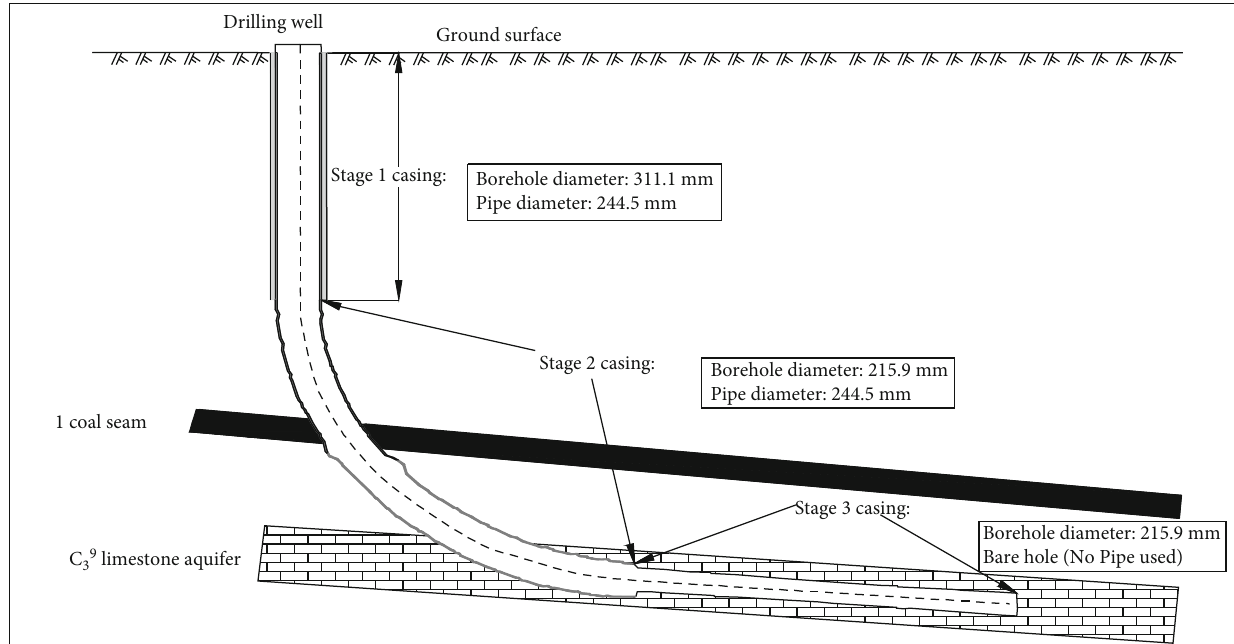
Figure 5: Schematic diagram of “ three casings ” drilling pro fi le